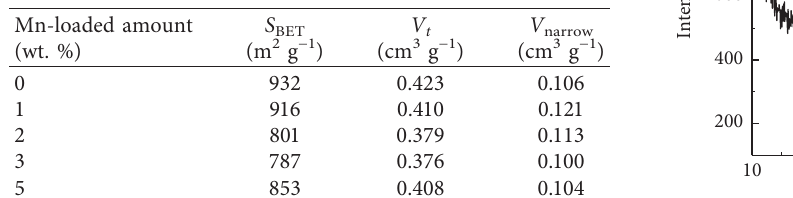
Figure 3: Pore size distribution curves of different Mn-loaded amount. Table 1: Corresponding parameters of texture properties with different Mn-loaded amount.